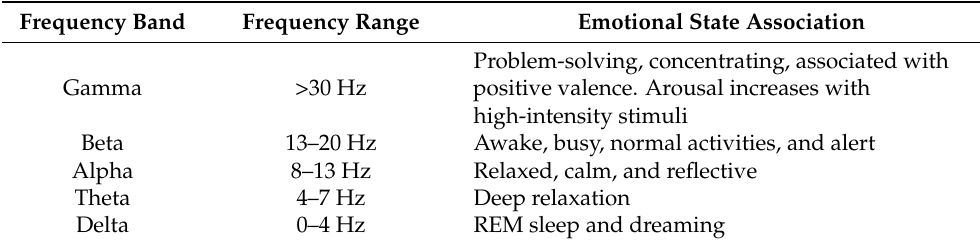
Table 1. Emotional state association of brainwaves at different frequency